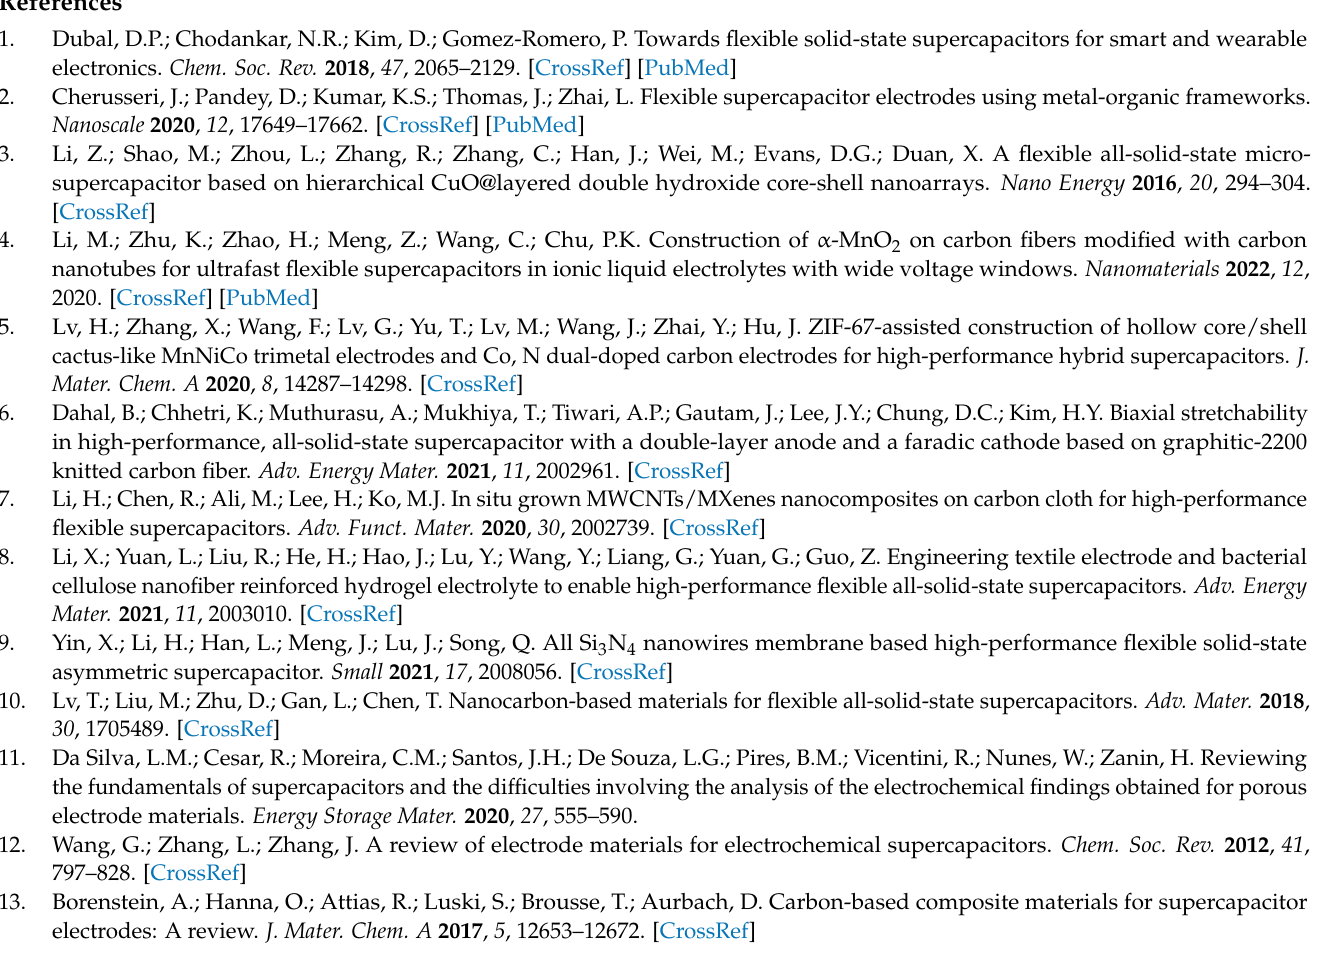
properties; Figure S1: characterization of C NPs. (a) SEM image. (b) XRD pattern; Figure S2: